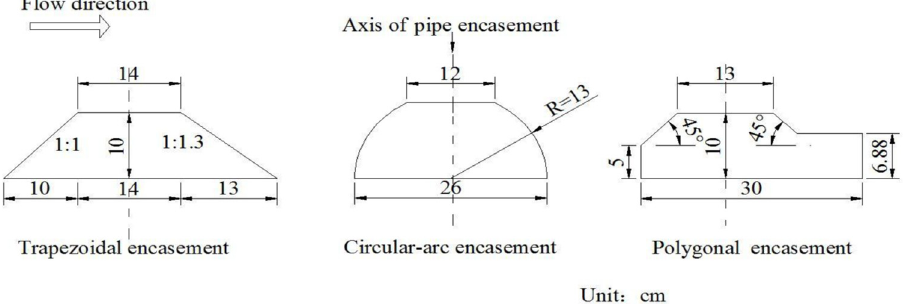
Fig 2. Cross-sections and dimensions of three types of pipe encasements used in the